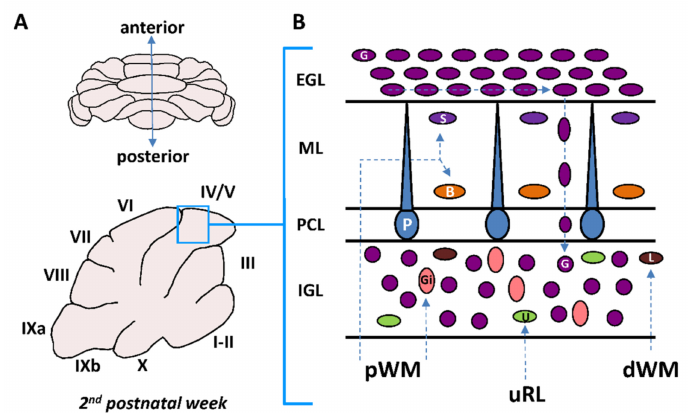
Figure 1. The cortex of the cerebellum: a unique model to study postnatal migration. ( A ) Complex foliated structure of the postnatal cerebellum with lobules (I–X) as shown in schematic sagittal section. IXa and IXb are sublobules of lobule IX. ( B ) Interneuron migration: from germinative zones to final location. dWM, deep white matter; pWM, prospective white matter; uRL, upper rhombic lip; EGL, external granular layer; ML, molecular layer; PCL, Purkinje cell layer; IGL, internal granular layer; Gi, Golgi cell; U, unipolar brush cell; G, granule cell; L, Lugaro cell; P, Purkinje cell; B, basket cell; S, stellate